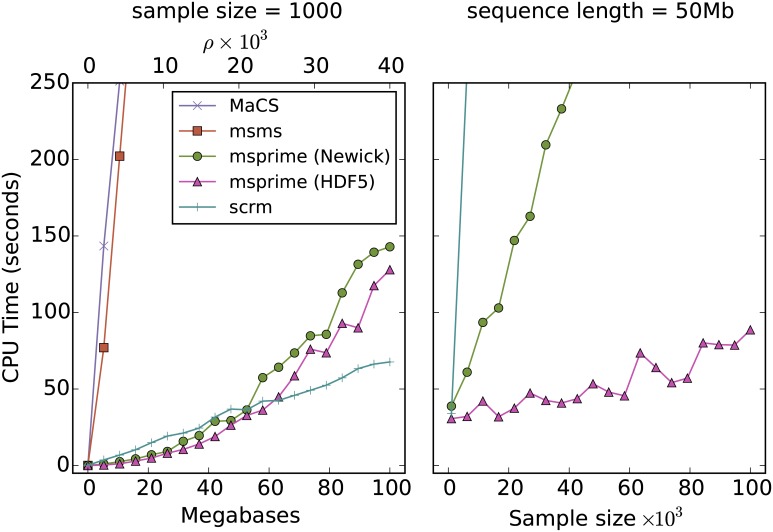
Comparison of the average running time over 100 replicates for various coalescent simulators with varying sequence length and sample size.
msms [34] is the most efficient published simulator based on Hudson’s algorithm that can output genealogies. MaCS [14] is a popular SMC based simulator, and scrm [16] is the most efficient sequential simulator currently available. Both MaCS and scrm were run in SMC′ mode. Two results are shown for msprime; one outputting Newick trees and another outputting the native HDF5 based format.